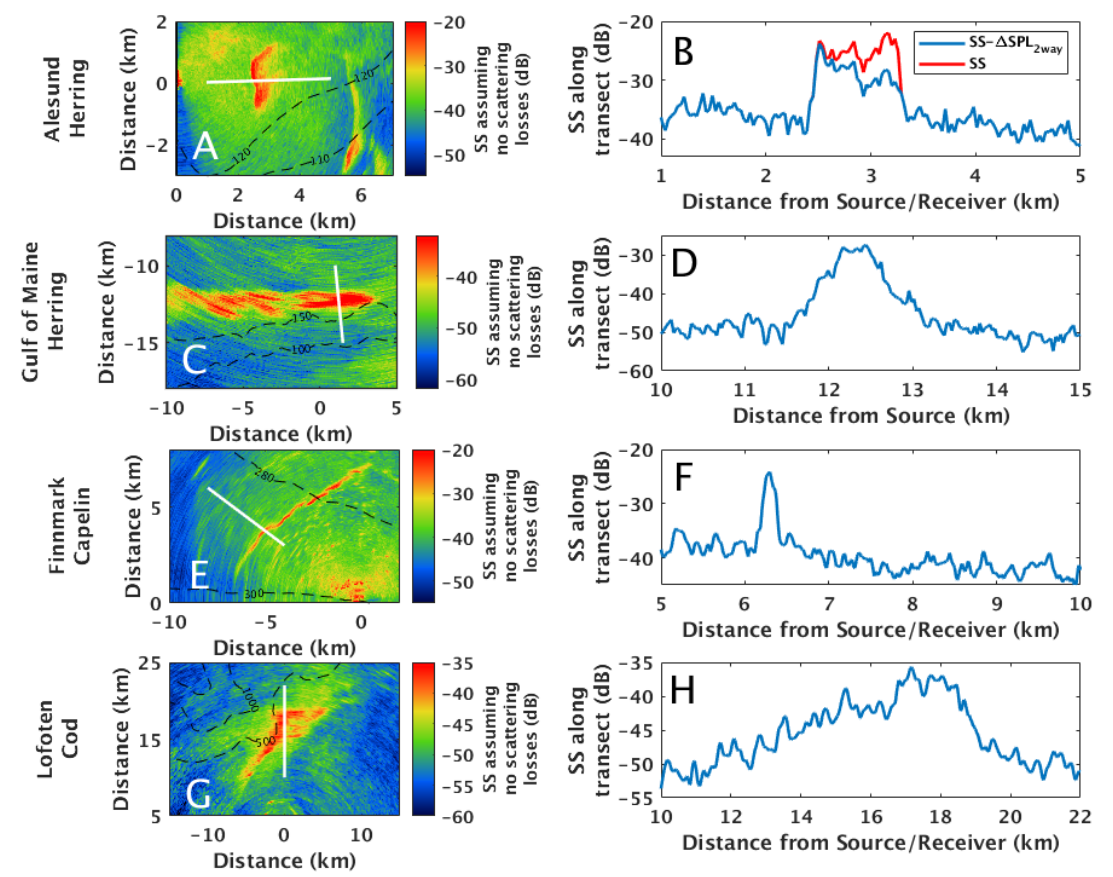
Figure A1. Example OAWRS scattering strength images of fish shoals assuming no scattering losses are shown from four separate continental shelf environments ( A , C , E , G ). Scattering strength levels along radial transects that bisect fish shoals are shown in ( B , D , F , H ). The positions of the radial transects are given by white lines in ( A , C , E , G ). We see evidence of attenuation through Ålesund herring shoals (blue line in ( B )) since there is a sharp increase in scattering strength where the shoal begins (2.5 km from the source/receiver) followed by a steady decease in scattering strength caused by attenuation as range increases. After applying the attenuation correction described in Section 3.3 this effect is no longer present (red line in ( B )). We do not see evidence of attenuation from Gulf of Maine herring, Finnmark capelin and Lofoten cod (( D , F , H ), respectively) since there is no steady decrease in scattering strength as range increases and no attenuation correction is necessary. Sensing frequencies for the scattering strength images shown here are 955 Hz for Ålesund herring, 950 Hz for Gulf of Maine herring, 955 Hz for Lofoten cod and 1335 Hz for Finnmark capelin. Black dotted lines indicate water depth